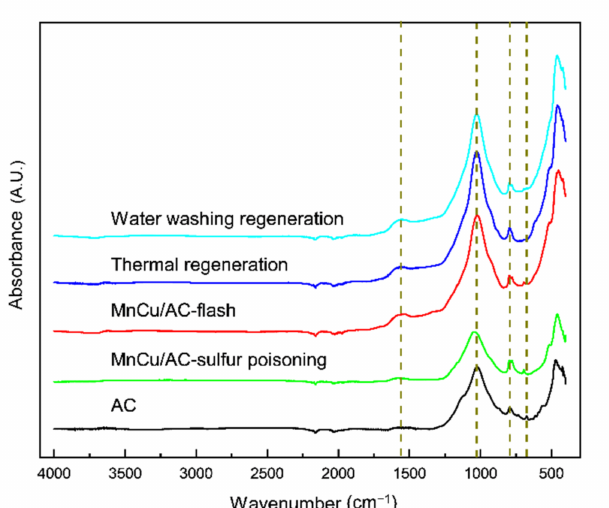
Figure 7. FTIR spectrum.